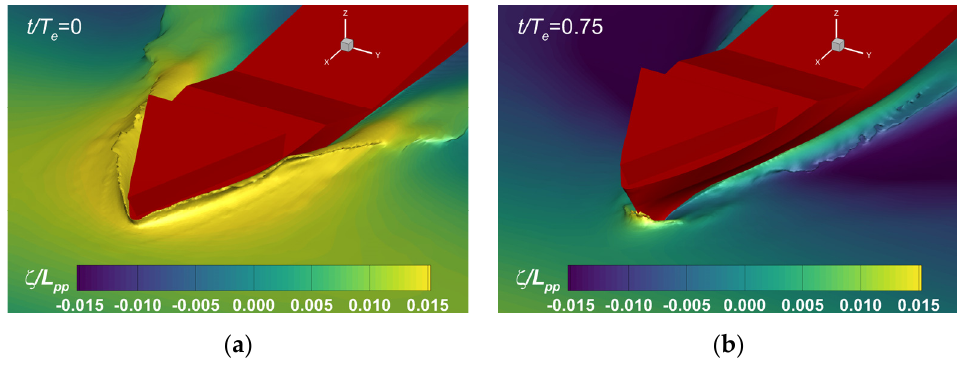
Figure 7. Bow wave profiles computed in the head sea case at: ( a ) 𝑡 𝑇 (cid:3032) ⁄ = 0 ; ( b ) 𝑡 𝑇 (cid:3032) ⁄ = 0.75